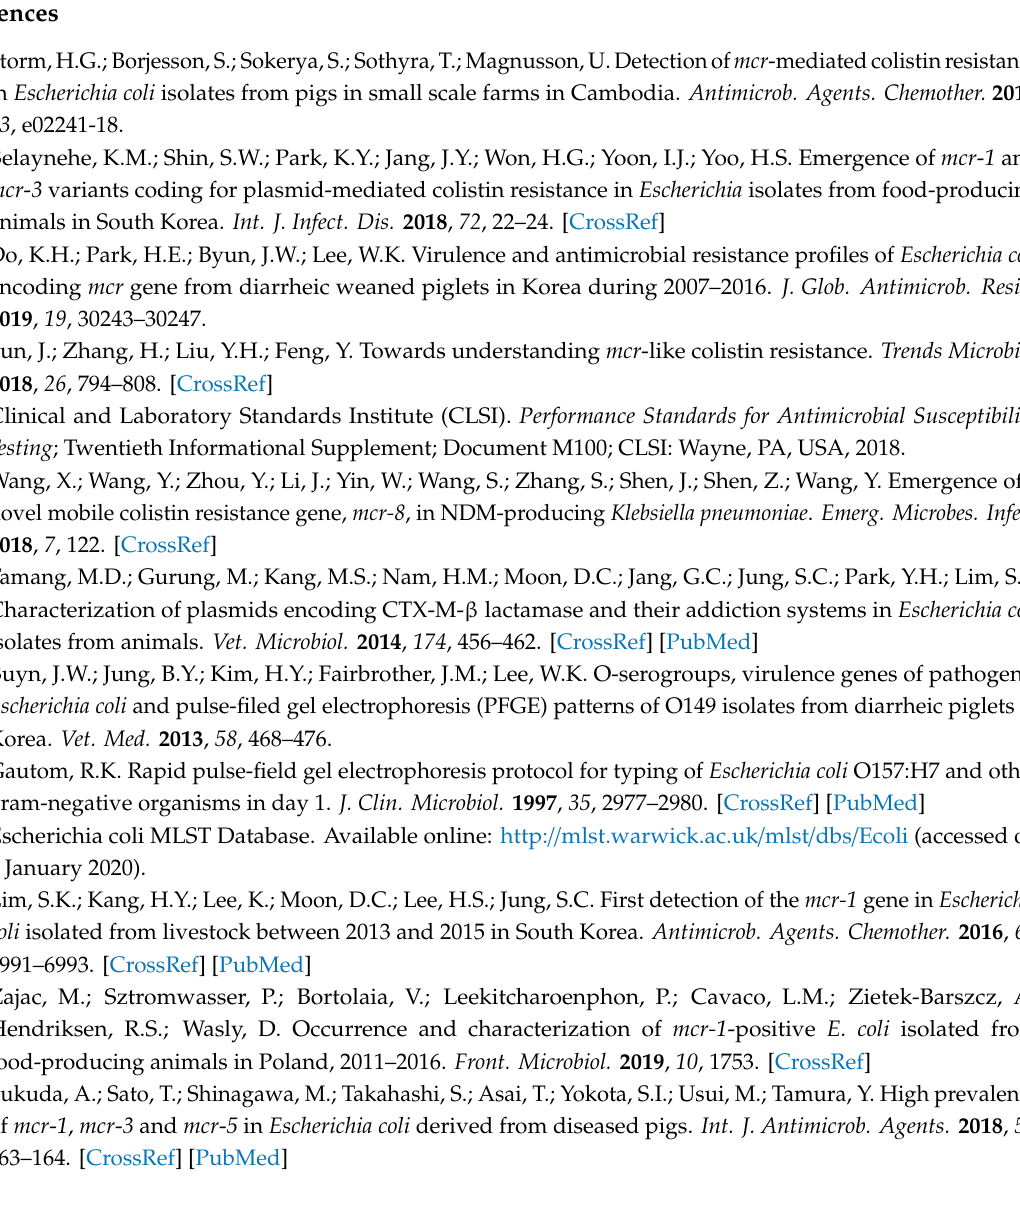
Figure S1 : X bal -digested pulsed-field gel electrophoresis patterns of mcr - 3 carrying E. coli strains isolated from healthy pigs, pig carcasses, and diseased pigs in Korea. X bal macrorestriction analysis yielded no DNA banding patterns in V01-R02-020 E. coli strain due to constant autodigestion of the genomic DNA during agarose plug preparation, and thus, a cluster formed by this strain is excluded. (ND, not